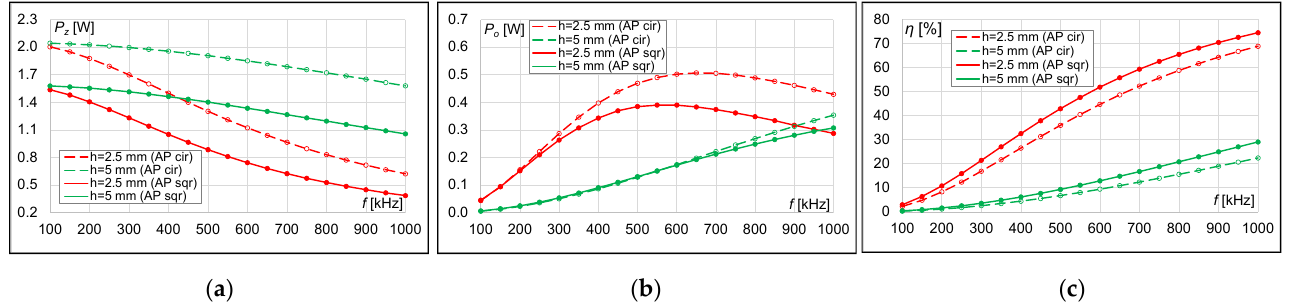
Figure 26. Results for the aperiodic system with circular or square coils with r = 5 mm and the number of turns n = 25 at two distances ( h = 2.5 mm and h = 5 mm): ( a ) transmitter power, ( b ) receiver power, ( c ) power transfer efficiency.